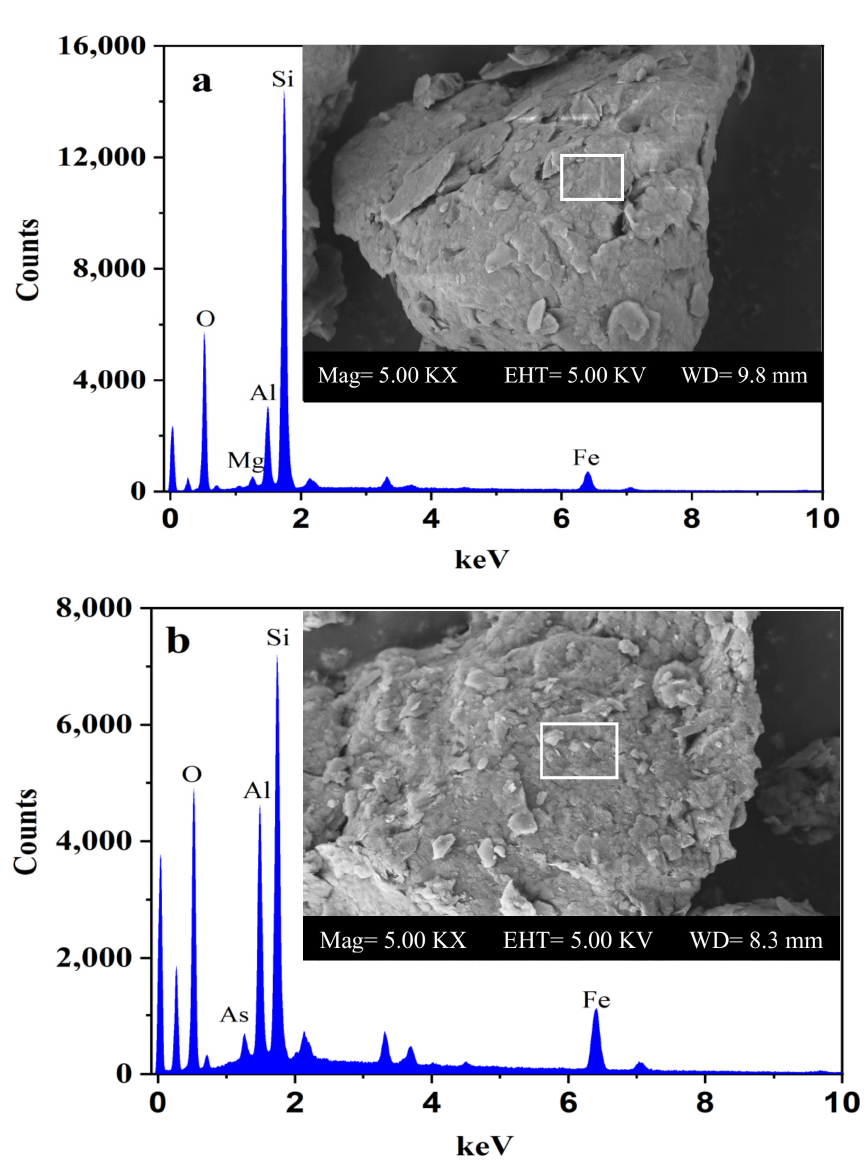
Figure 6. Scanning electron microscope (SEM) photos and energy dispersion spectrum (EDS) of sediment samples before ( a ) and after ( b ) MTAs V adsorption. Table 4. Characterization parameters of sediment before and after MTA adsorption.